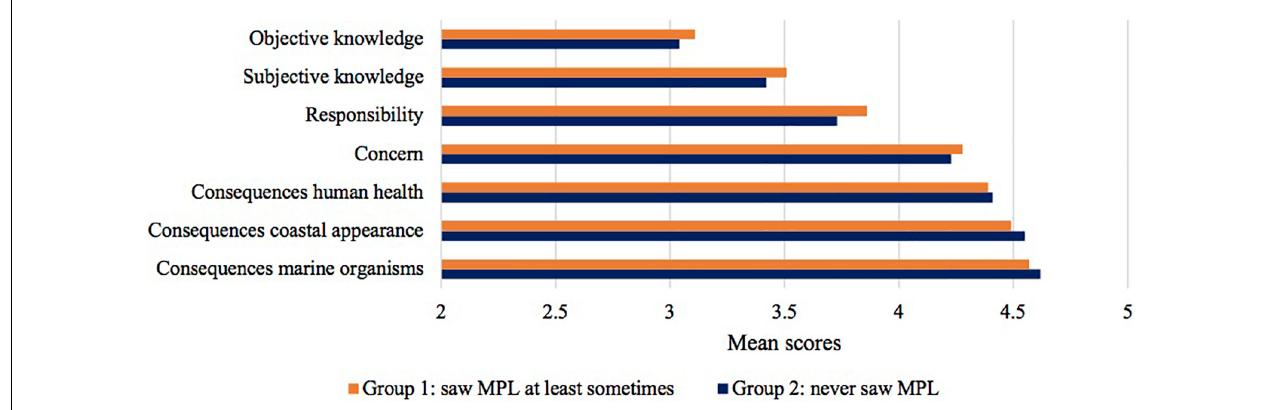
FIGURE 3 | Comparison of mean scores across respondents who saw MPL and who reported that they never saw MPL during their beach visit (response options range from 1 to 5: totally disagree–totally